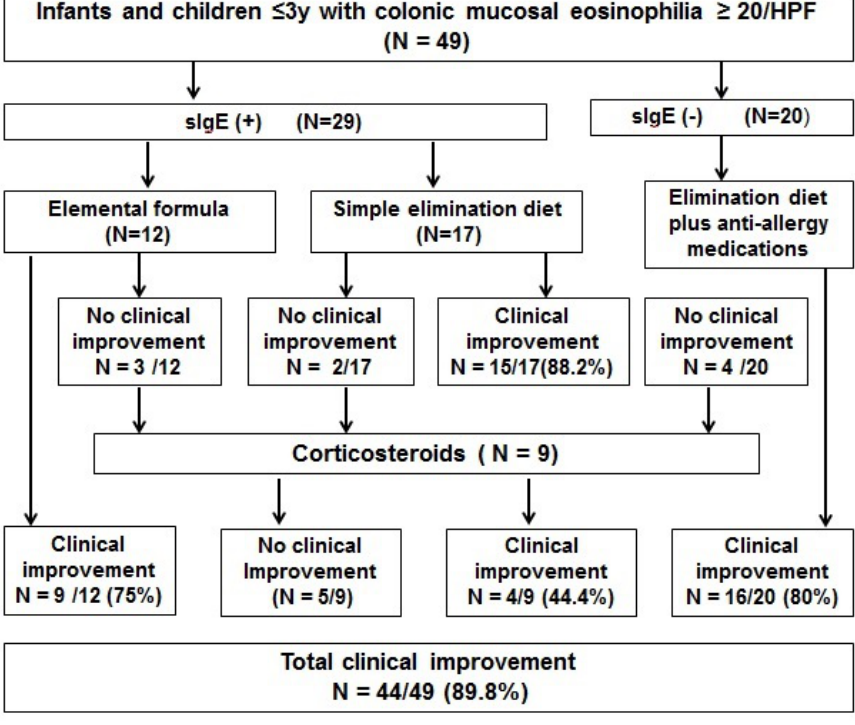
Figure 2. Treatment outcomes for infants and children with eosinophilic